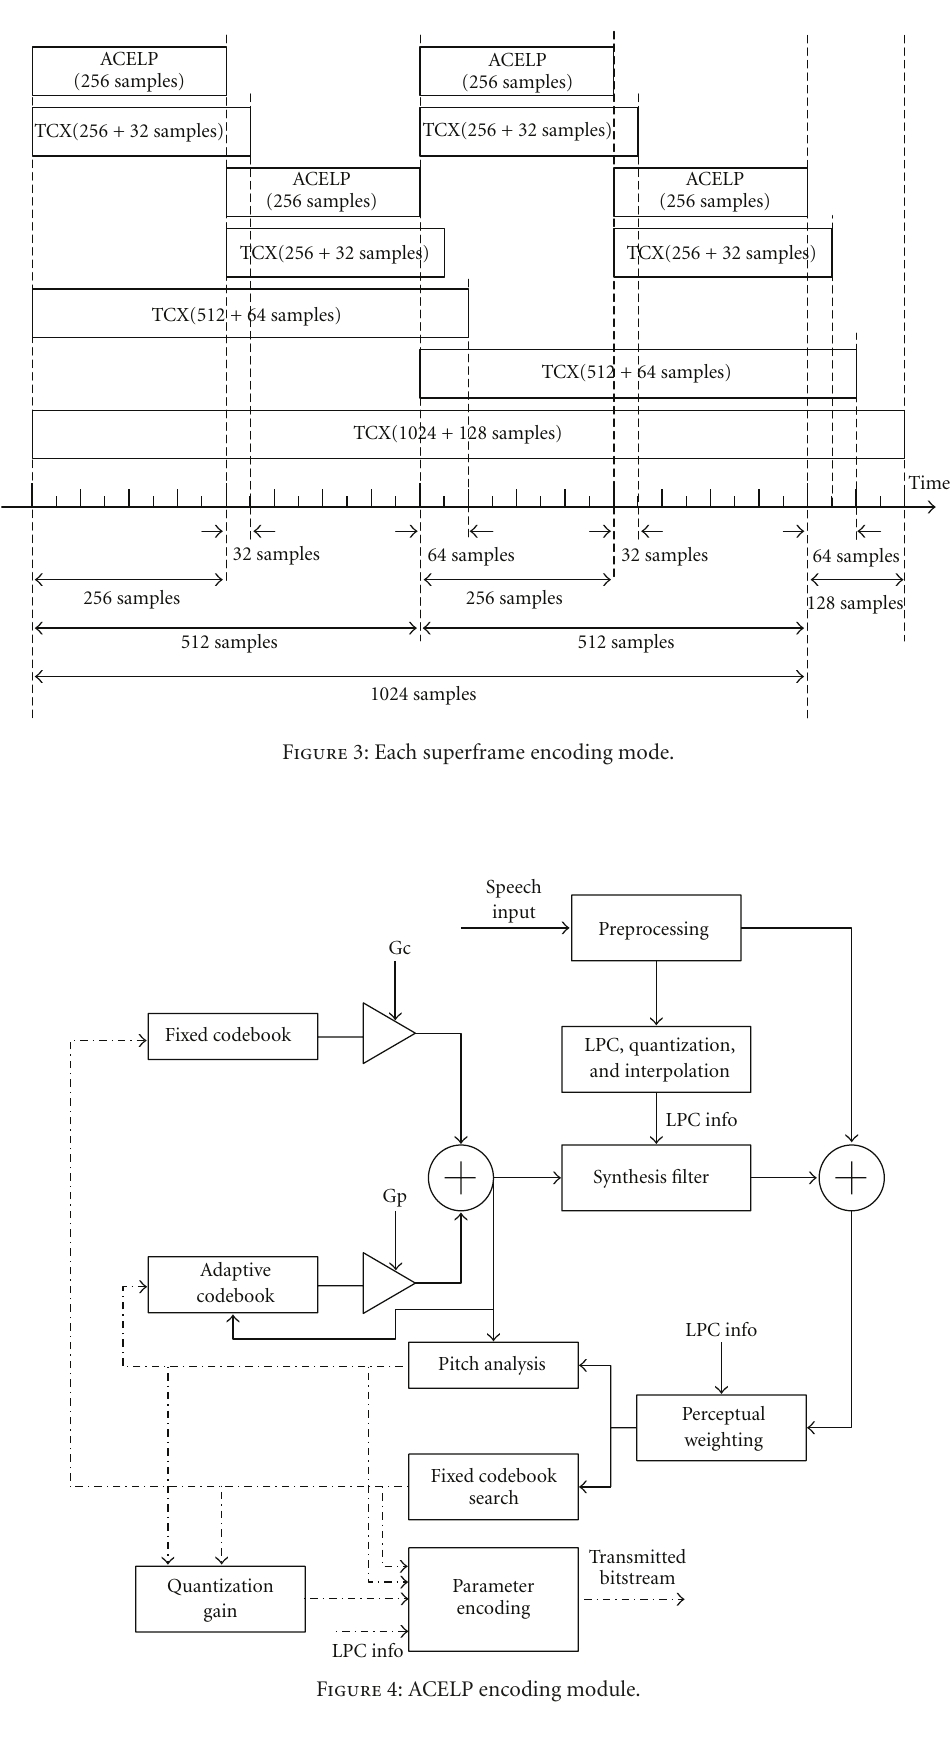
Figure 4: ACELP encoding